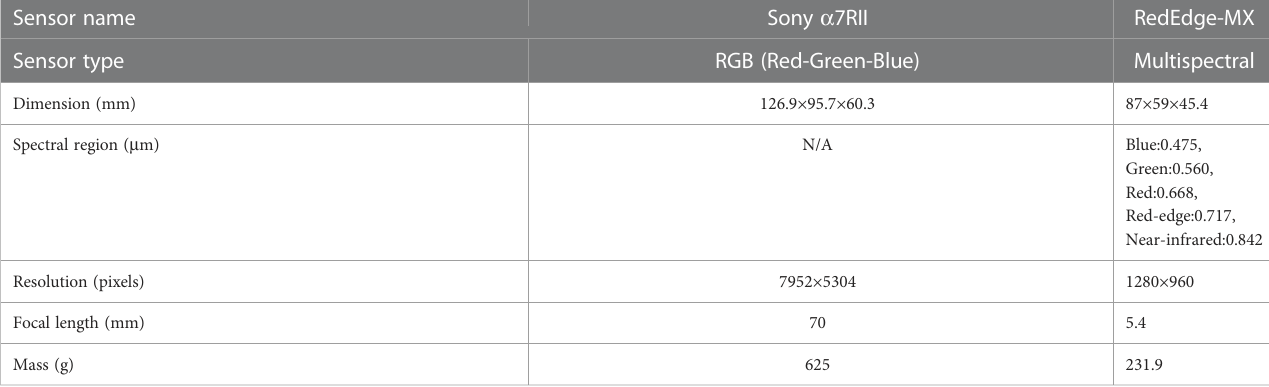
TABLE 1 Basic parameters of the sensors mounted on the UAV.